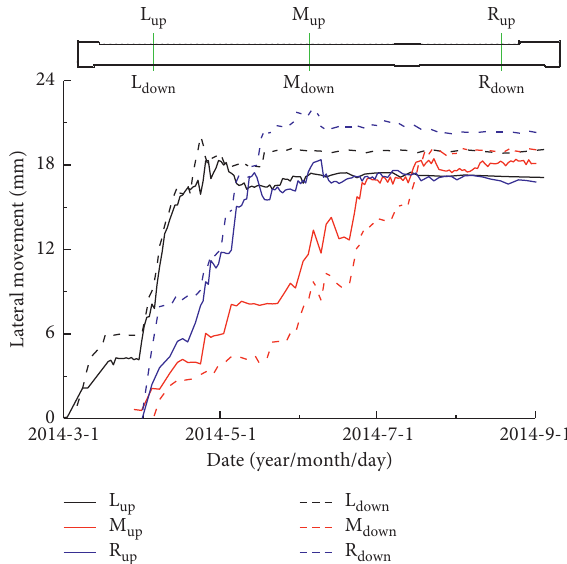
Figure 8: Lateral movement of retaining structures at the depth of 15m.